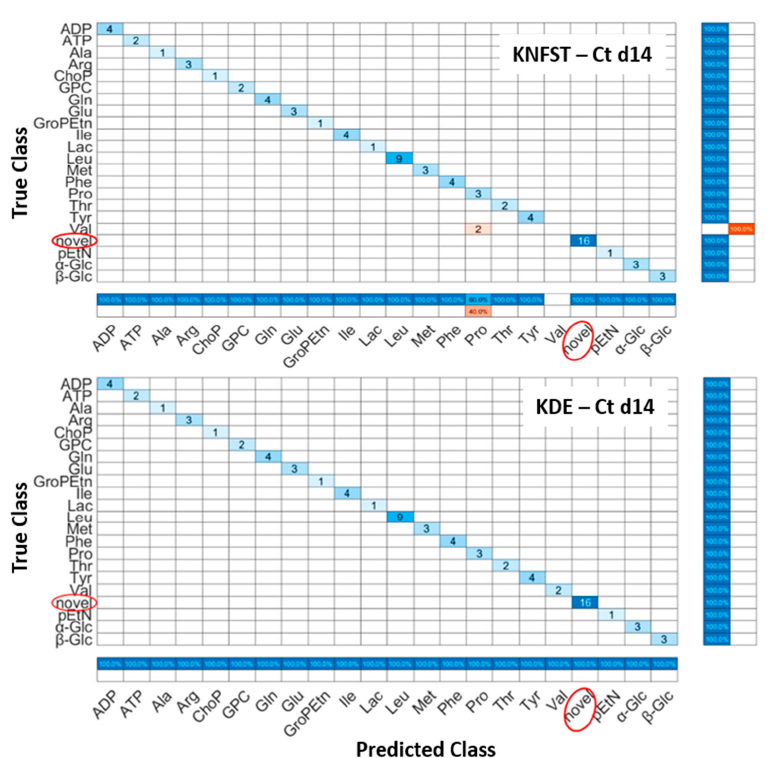
Figure 6. Confusion matrices of the output of classifiers KNFST and KDE for the spectra of 14 days of cultivation.